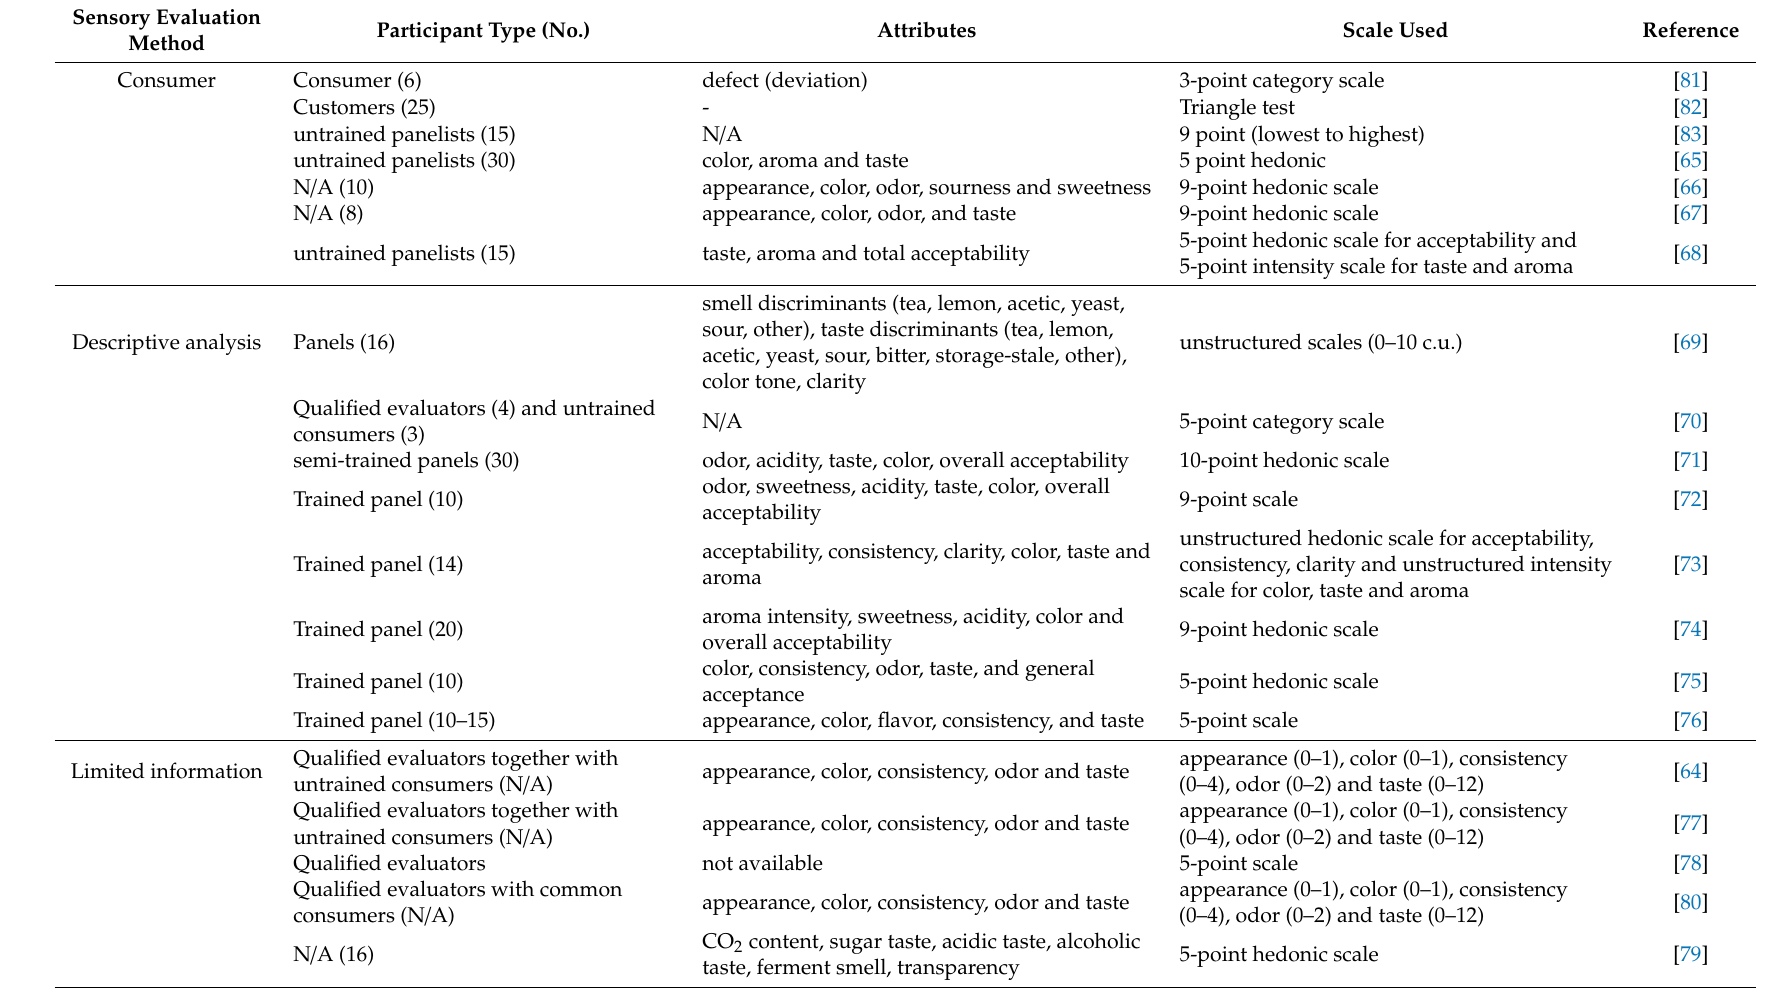
Table 9. Sensory evaluation details of kombucha and the sensory and consumer research available in the